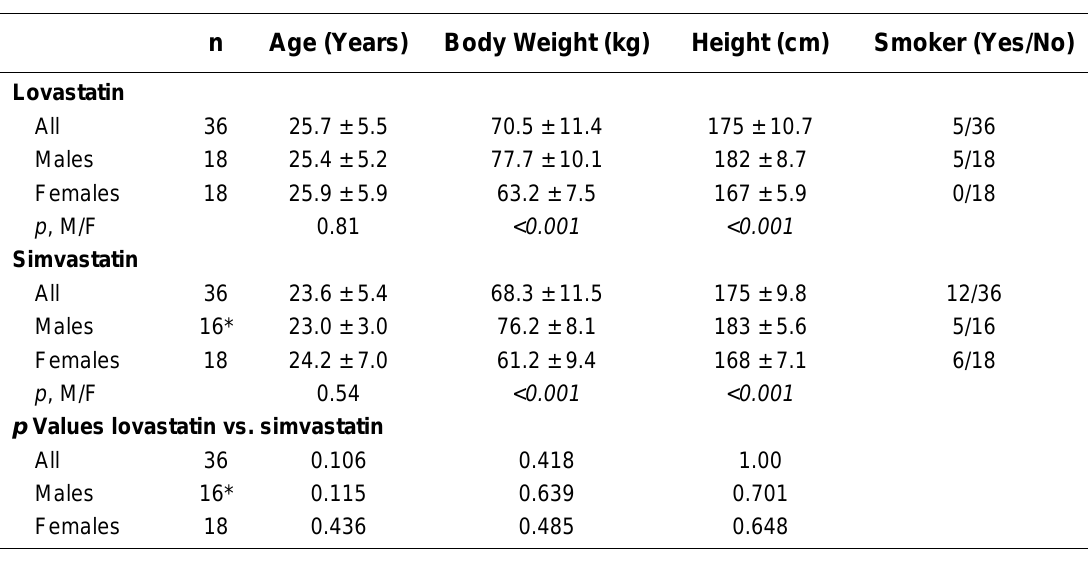
Demographic Data of the